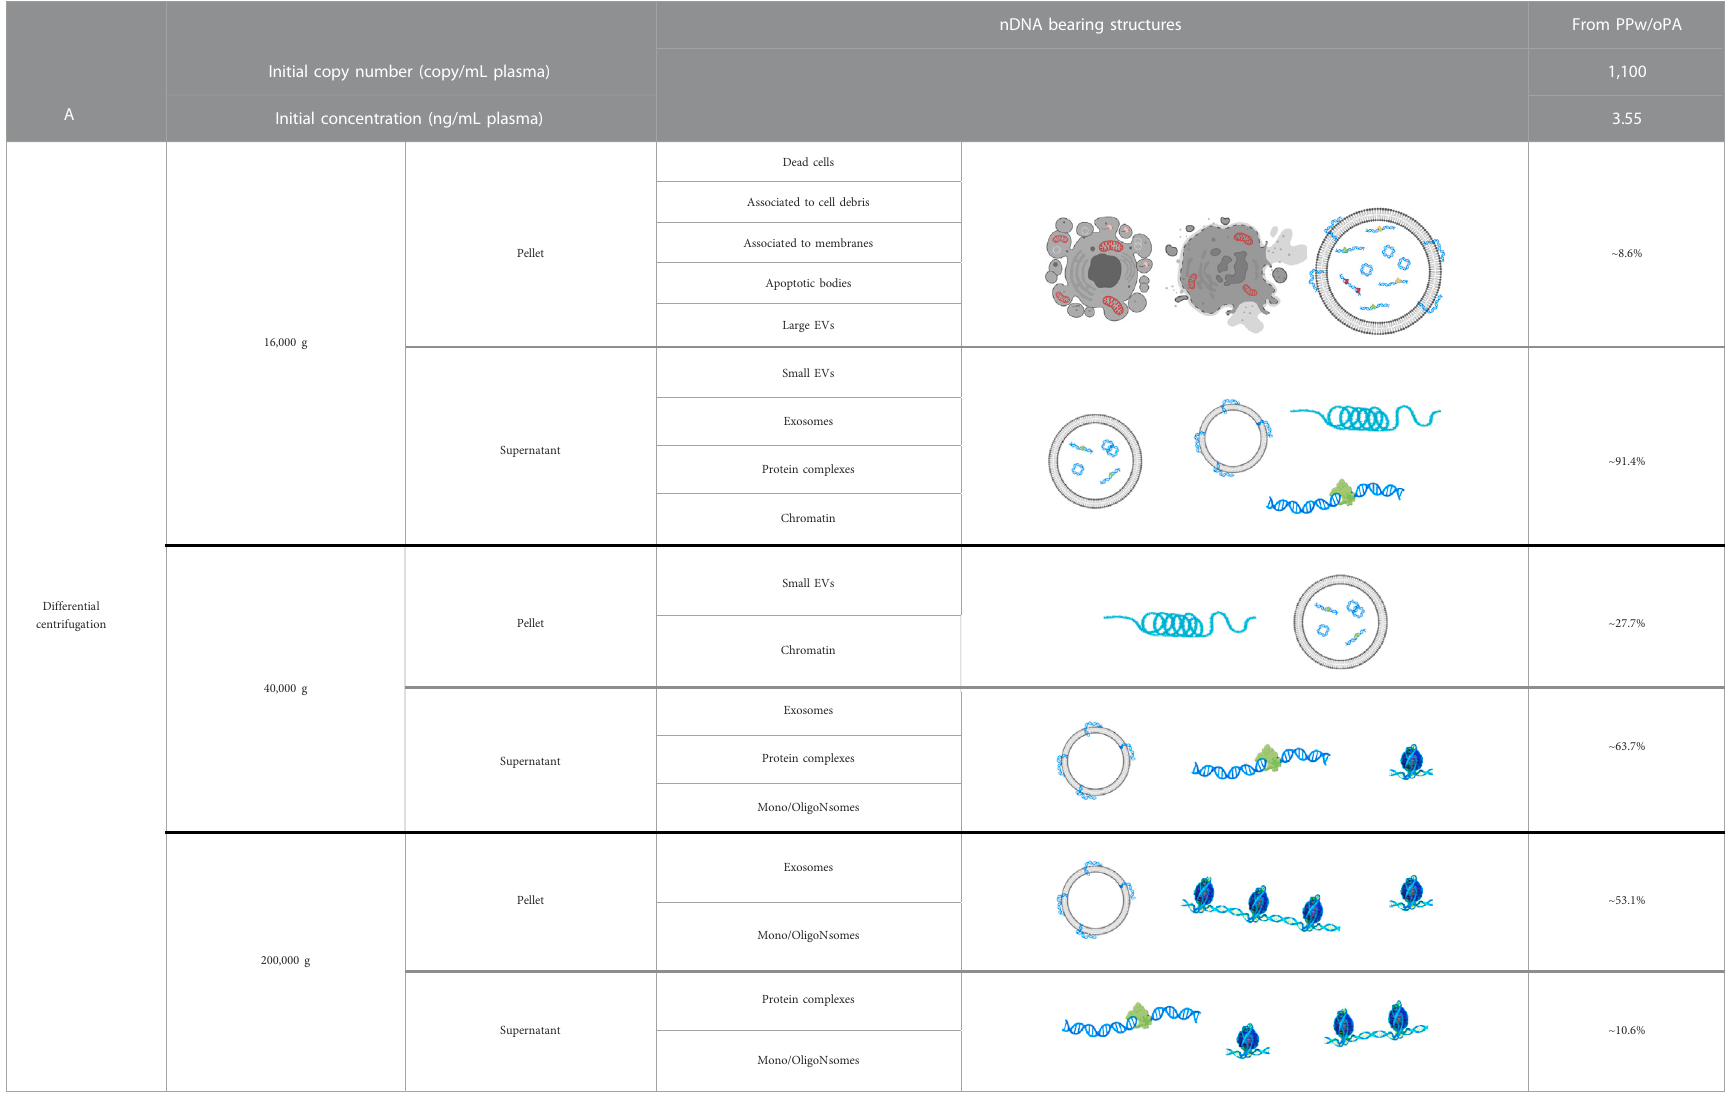
TABLE 1 Suggested repartition of structures containing circulating DNA (cirDNA) in plasma. cirDNA content was measured in supernatant after successive centrifugations at different speeds, respectively 400 g with Ficoll gradient(initialcopynumber); 16,000;40,000and200,000 gfollowingthepreparation protocolwithout plateletactivation(PPw/oPA). cirDNAcontentinthepelletwasinferredfromthisofthesupernatant ateachstep.While exosomes, andapoptotic bodies could be considered as extracellular vesicles (EVs), we arbitrarily differentiate here fourtypes of vesicles: large EVs,small EVs,exosomes, andapoptotic bodies. A: nuclear cirDNA (cir-nDNA); B: mitochondrial cirDNA (cir-mtDNA); mtDNA, mitochondrial DNA; nDNA, nuclear DNA; EVs, extracellular vesicles; oligoNsomes,